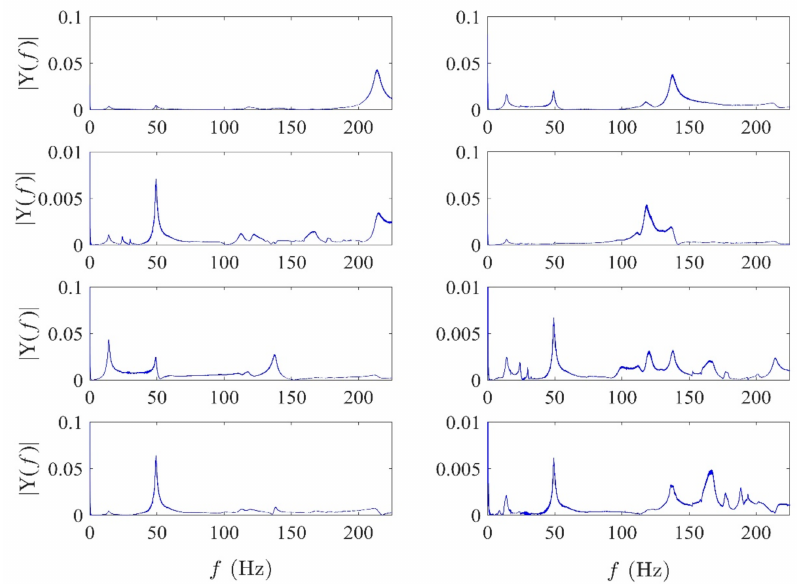
Figure 11. Fourier spectra of SOBI results obtained from R+25 test conducted on the wind turbine blade.